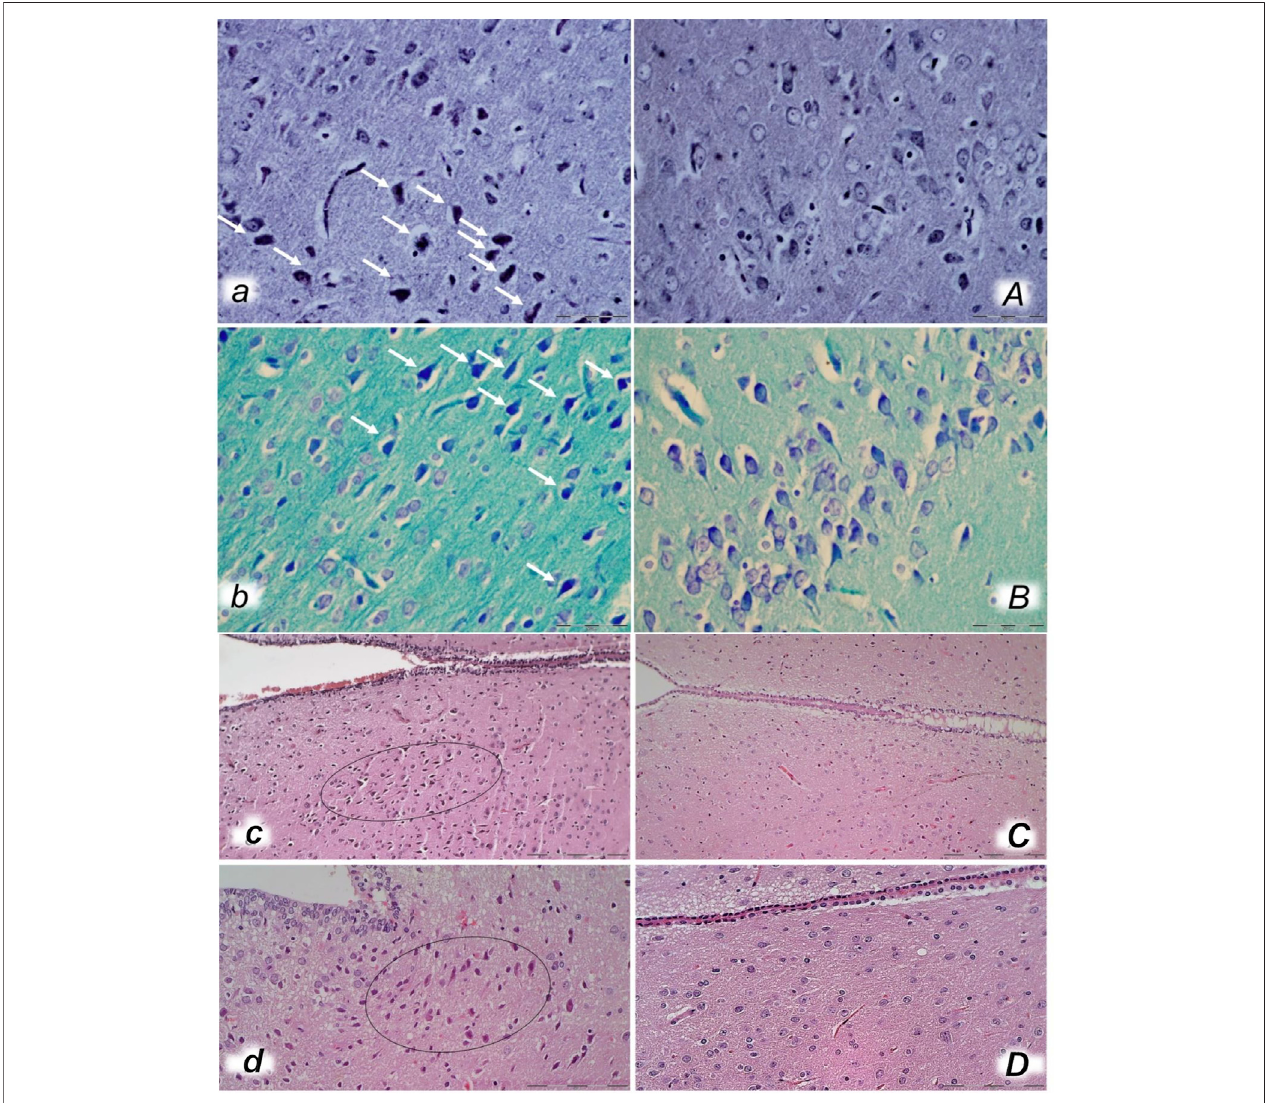
FIGURE 14 | Bielschowsky and Klüver – Barrera histochemical staining presenting neuropathological changes of cerebral cortex in rats with the increased intra- abdominal pressure at 30 mmHg for 30 min ( a, A, b, B ) treated at 10 min increased intraabdominal pressure time with saline (control a, b ) or BPC 157 ( A, B ). In control rats, an increased number of karyopyknotic cells was found in the cerebral cortex (white arrows) ( A, B ) that was signi fi cantly different from the cortex area in BPC 157- treated rats ( a, b ). (Bielschowsky staining ( a, A ); Klüver – Barrera staining ( b, B ); magni fi cation × 600, scale bar 50 μ m). Neuropathological changes of hypothalamic/ thalamicarea( c,C,d,D )presentationinratswiththeincreasedintra-abdominalpressureat25 mmHgfor60 min( c,C )orat50 mmHgfor25 min( d,D ),treatedat10 min increasedintra-abdominalpressuretimewithsaline(control, c,d )orBPC157( C,D ).Amarkedkaryopyknosiswasfoundinallcontrolrats(markedinoval)( c, 25 mmHg/ 60 min); d, 50 mmHg/25 min) while preserved brain tissue was found in BPC 157-treated rats ( C, 25 mmHg/60 min); D, 50 mmHg/25 min). (HE; magni fi cation × 400, scale bar 50 μ m).